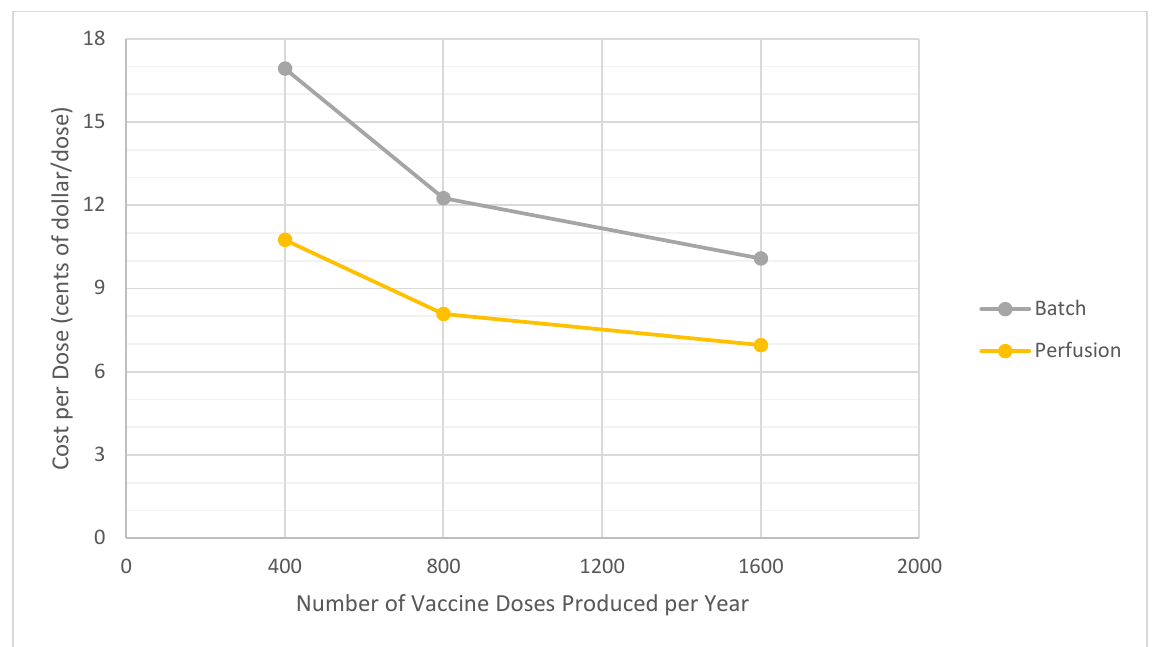
Figure 6. Effect of production scale on the total operating cost (in terms of cost per dose). The viral production yield is 1 × 10 11 VP/mL for the batch process and 2 × 10 12 VP/mL for the perfusion process.